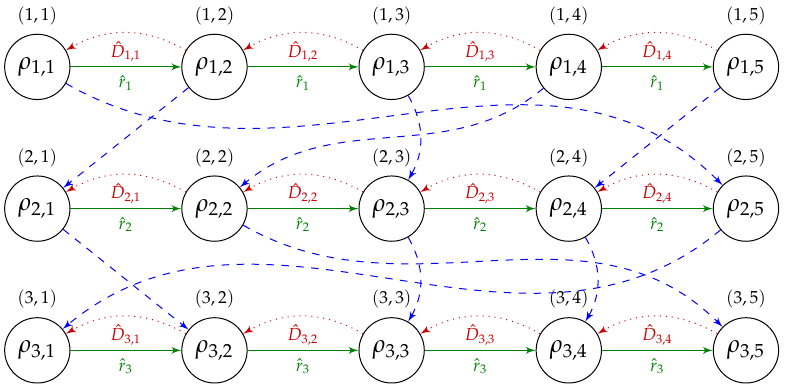
Figure 2. Example of graph G ( π ) for solution π = (( 1,2,3,4,5 ) , ( 2,4,3,5,1 ) , ( 1,2,3,5,4 )) from Example